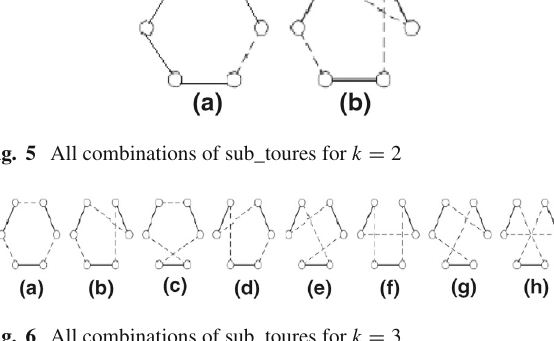
Fig. 6 All combinations of sub_toures for k = 3